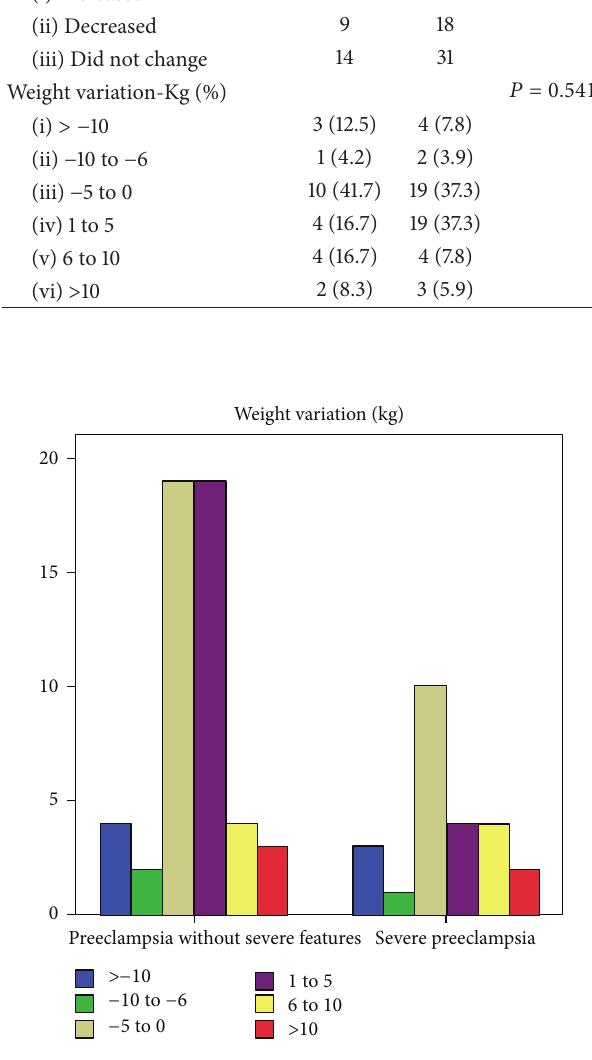
Figure1:Weightvariationdistributioninwomenwithpreeclampsia without severe features and with severe